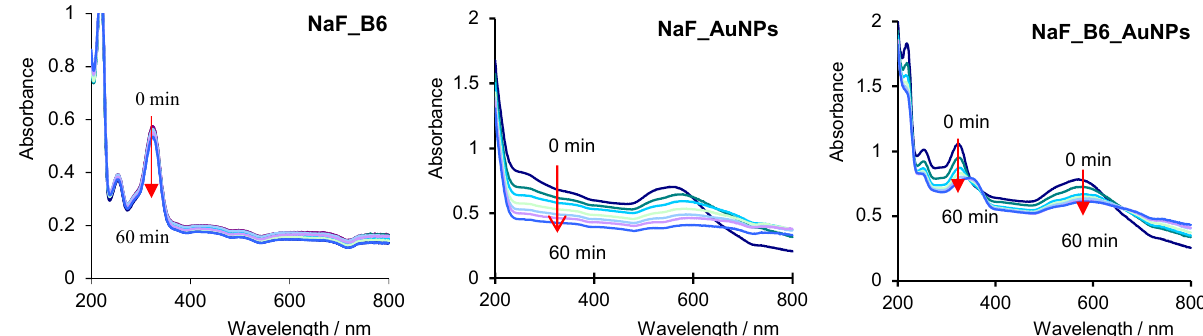
Figure 3. UV–Vis absorption spectra of work electrolyte solution as the electrochemical processes progress over time in NaF/B 6 /AuNP systems (i = 50 mA × cm − 2 ).